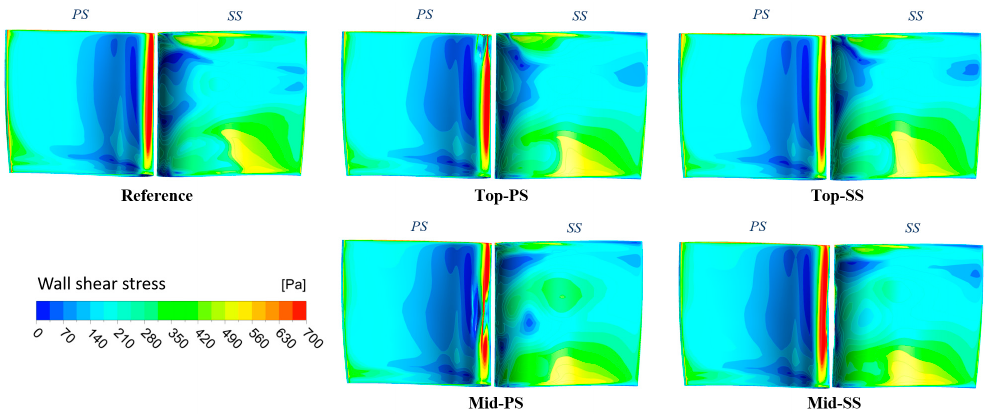
Figure 8. Wall-shear stress distribution on the rotor blade surface.